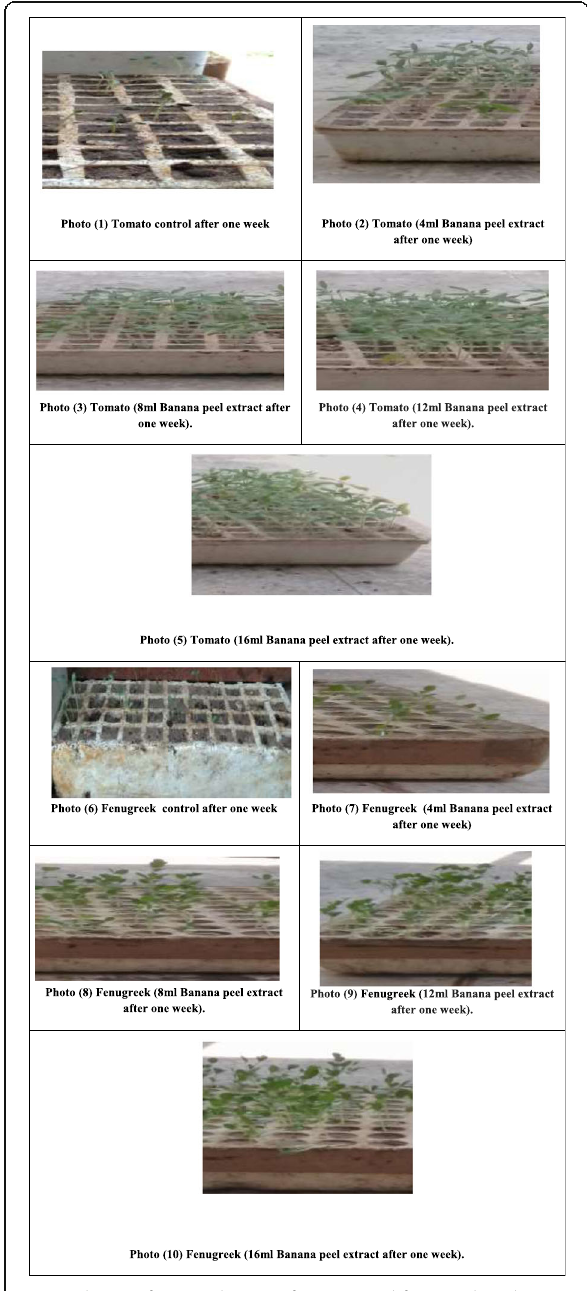
Fig. 5 Photos of irrigated crops of tomato and fenugreek and their